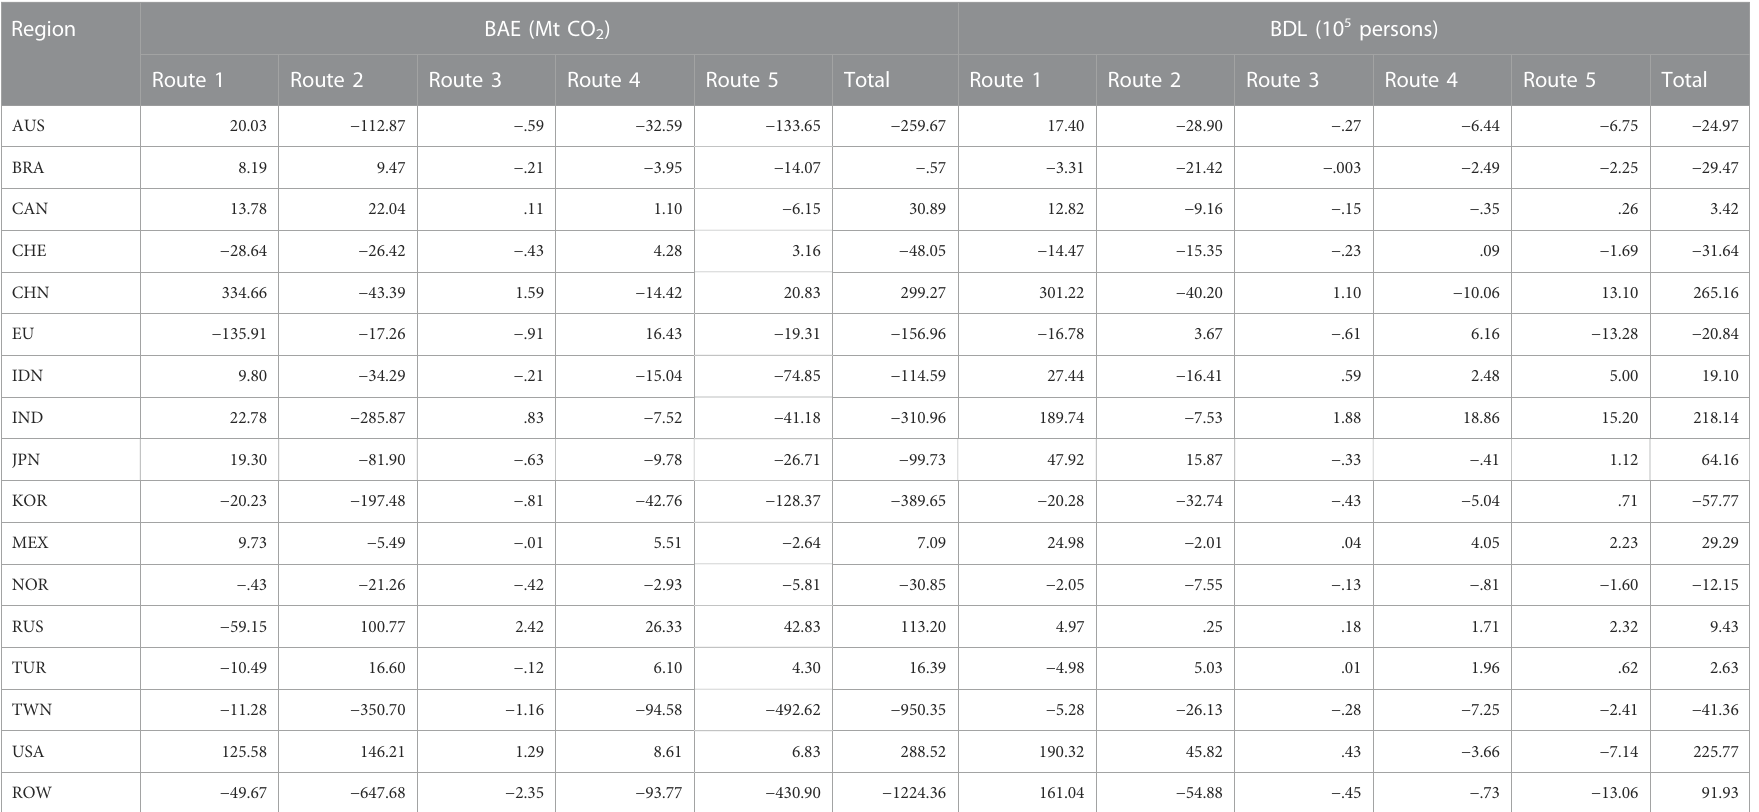
TABLE 4 Environmental and employment impacts of each economy ’ s trade activity in 2014.